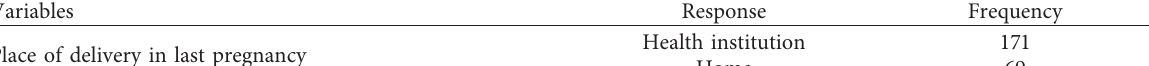
Table 4: Place of delivery practice among women who gave birth in the last one year at Serbo, Kersa Woreda, Southwest Ethiopia, July 2021.